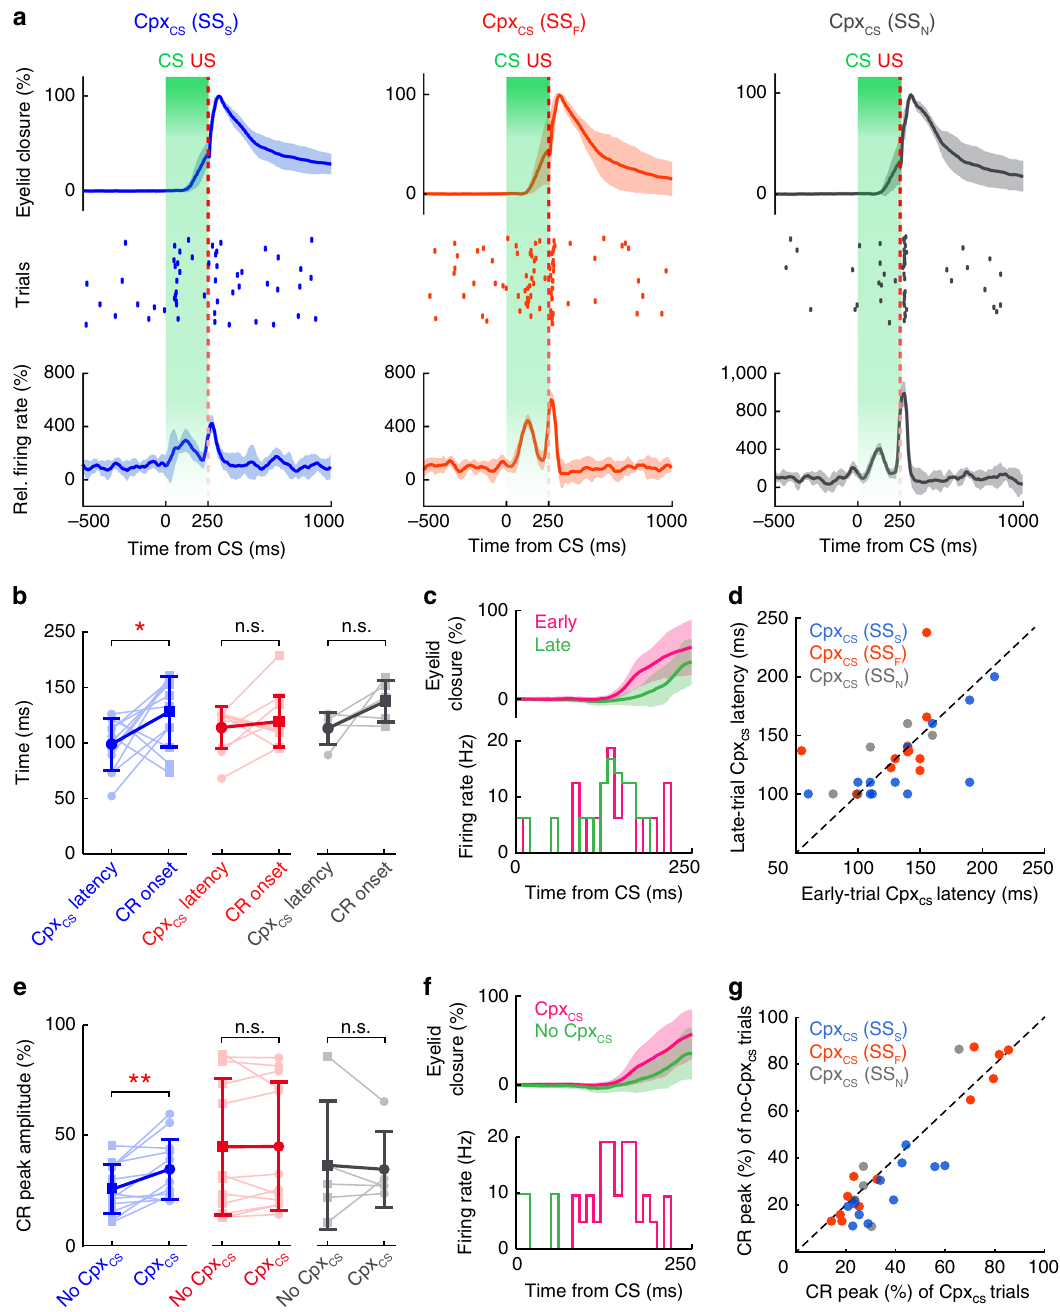
Fig. 4 Purkinje cell complex spikes encode CR-related information. a Complex spike modulation during DEC. PCs with CS-related complex spikes (Cpx CS ) are color-coded based on their simple spike (SS) modalities: suppression (Cpx CS (SS S ), blue), facilitation (Cpx CS (SS F ), red) and no modulation (Cpx CS (SS N ), gray). Top row: summary of eyelid responses (left to right: n = 30, 32, 41 trials, mean ± SD). Middle row: example complex spike activity (raster plots of spike events) during DEC, and bottom row shows average Cpx CS activity of each PC population (left to right: n = 12, n = 12, n = 5 neurons, mean ± s.e.m.). b Comparison between the timing of Cpx CS (Cpx CS latency) and the CR onset. Only PCs with simple spike suppression showed an earlier occurrence of Cpx CS than CR onset (mean ± SD, paired two-sided t test, left to right: n = 12, 12, and 5, P = 0.04, 0.51, and 0.14). c Comparison of Cpx CS latency in trials divided into early ( n = 16 trials, 147.4 ± 23.6 ms, mean ± SD) and late trials ( n = 16 trials, 196.8 ± 21.2 ms, mean ± SD) based on CR onset. Example recording of Cpx CS during the CS – US interval ( fi ring rate PSTH, c , bottom) in the early and late CR trials ( c , top). d Population summary showing no difference in Cpx CS latency between early and late trials in any category of PCs (paired two-sided t test, P = 0.39). e Comparison of CR peak amplitudes in trials with and without Cpx CS . The occurrence of Cpx CS in the PCs with simple spike suppression predicts a larger CR amplitude (mean ± SD, paired two- sided t test, left to right: n = 12, 12, and 5, P = 0.005, 0.94, and 0.80). f Example traces of CRs (top, n = 21 trials for pink trace, n = 10 trials for green trace, mean ± SD) with or without Cpx CS ( fi ring rate PSTH, bottom). Cpx CS is de fi ned as the complex spikes that occur within 50 – 250 ms following CS onset. Correlation of Cpx CS occurrence and CR peak amplitude for three categories of Purkinje cells is summarized in ( g ). PCs with simple spike suppression (Cpx CS (SS s ), blue) reside below the diagonal